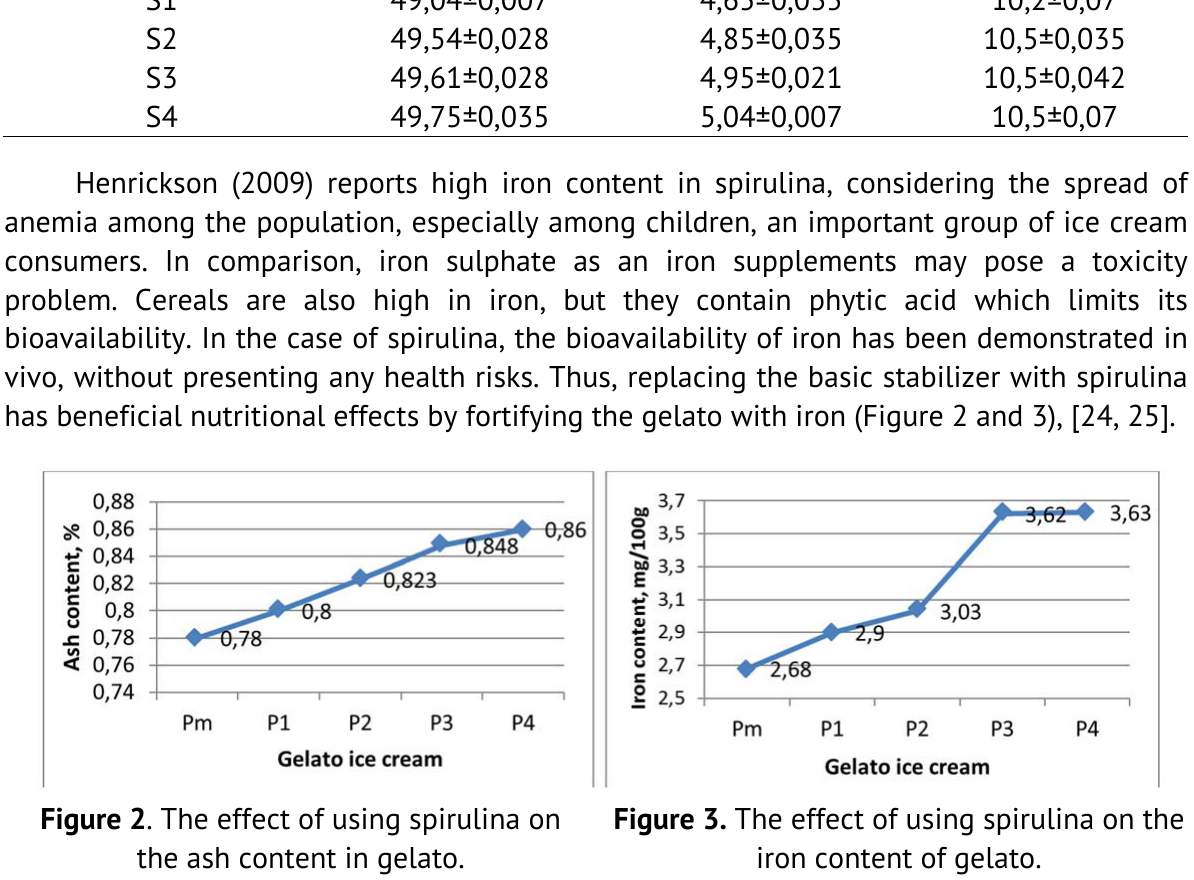
Figure 2 . The effect of using spirulina on the ash content in gelato.